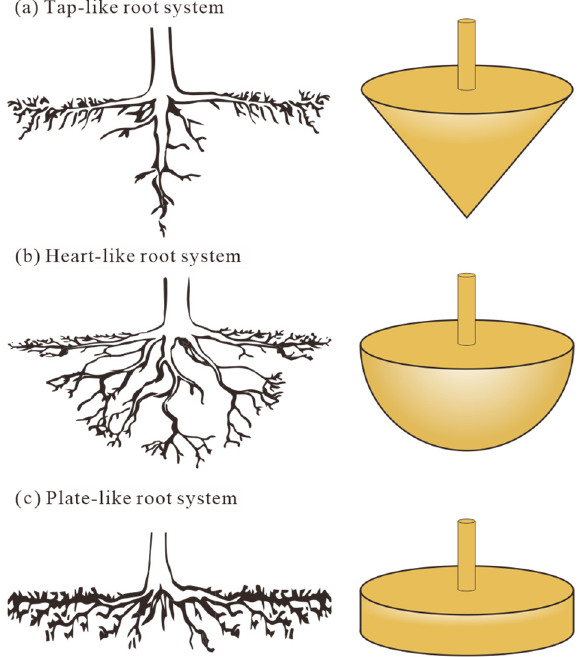
Figure 3. Schematic diagram of root system morphologies and their corresponding geometrical models of root-soil composites. ( a ) Tap-like root system; ( b ) Heart-like root system; ( c ) Plate-like root system.